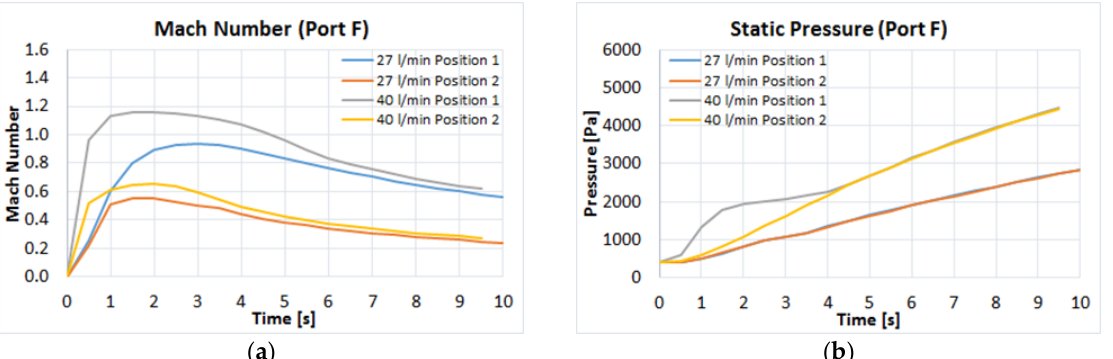
Figure 22 . Mach number ( a ) and pressure ( b ) versus time, F port, 27 and 40 L/min As shown, the Mach number is lower than for the C and E ports, and there are no fluctuations because there is only one stable vortex. For this port, it can be seen that when the flow exiting from